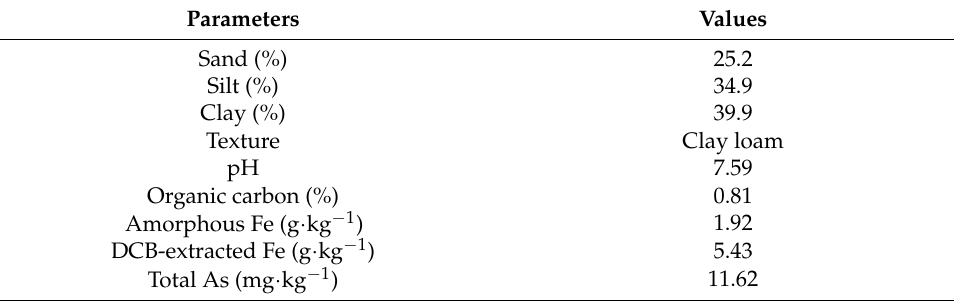
Table 1. Initial physicochemical properties of experimental